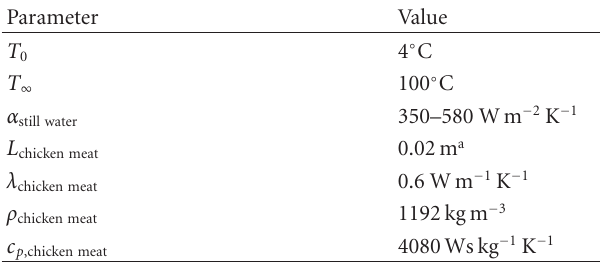
Table 1: Parameter values for estimating the temperature profile of a chicken fillet in boiling